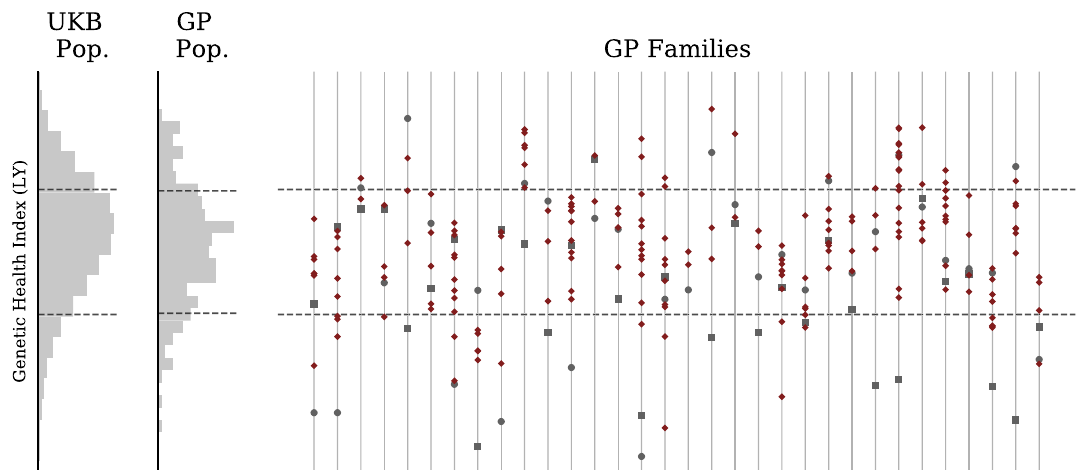
Figure 9. Genetic Health Index value distributions in the UK Biobank are similar to those of GP parents and embryos. Top-left: UK Biobank vs all GP samples. Top-right: GP parent samples vs GP embryo samples. Bottom-left UK Biobank vs parent samples. Bottom-right: UK Biobank vs embryo samples.